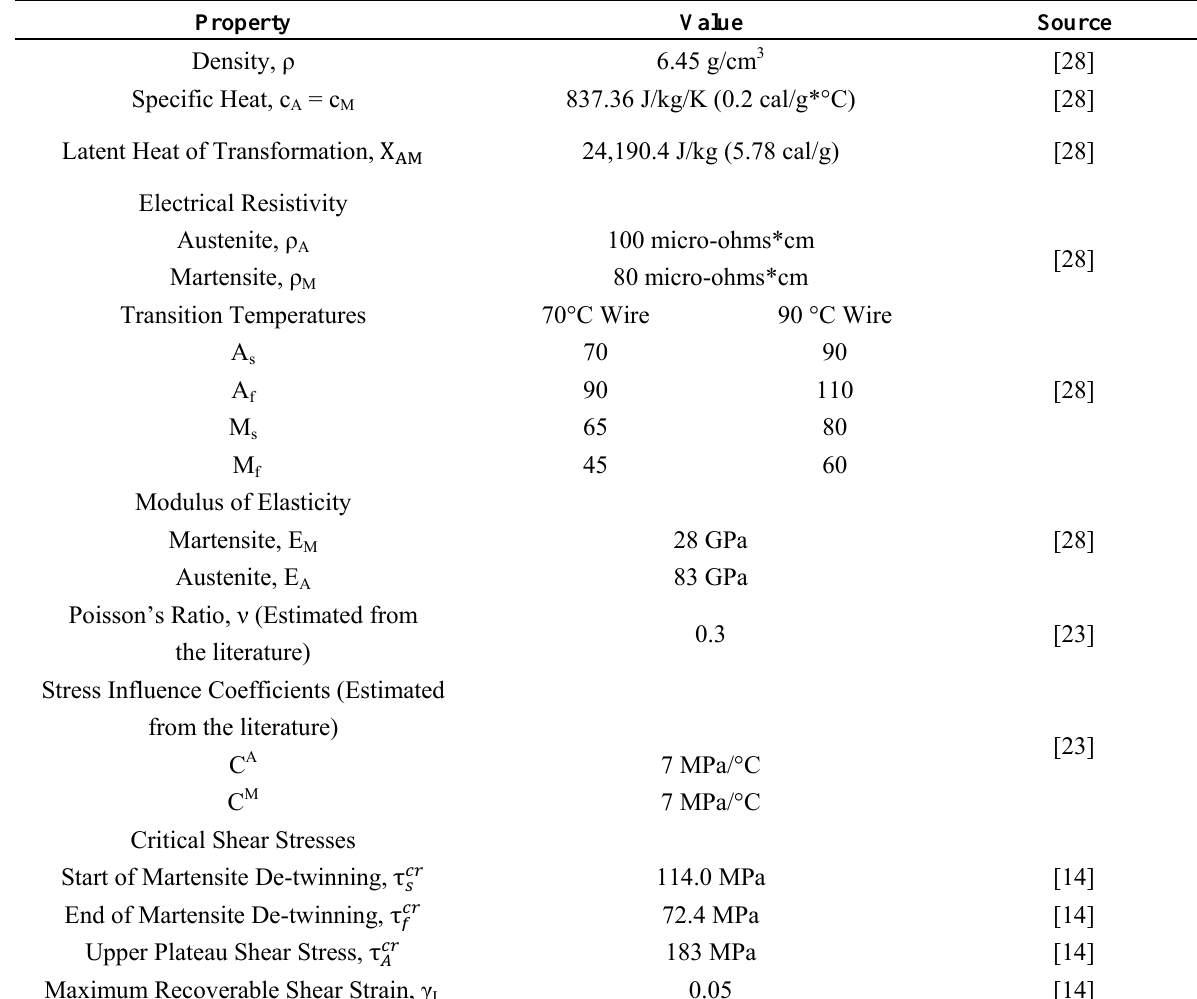
Table 2. The material properties of the shape memory alloy (SMA) wire and estimated material